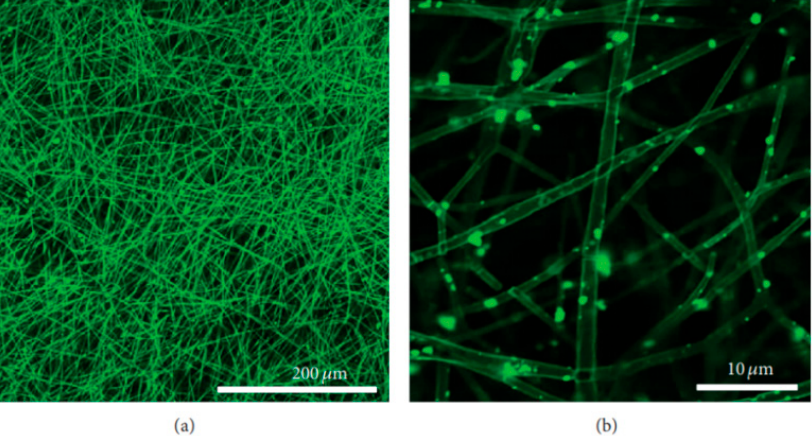
Figure 23. Confocal fluorescence images of FITC-labeled BMP-g-nHA/PLGA hybrid nanofiber scaffolds at low ( a ) and high ( b ) magnifications [21].